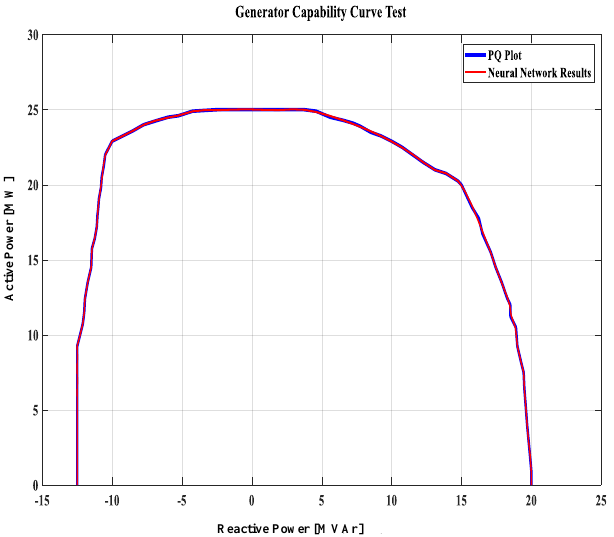
Figure 14. The developed capability curve of a generator with neural network training. The capability curve from the NN training results already recognizes the target as the initial capability curve, which are the 𝑃𝑄 curve data. It is proven that the capability curve of the NN training results (red line) is similar to the 𝑃𝑄 curve data target (blue • Working Point of Generator line). A trial of the capability curve of the NN training results was carried out to obtain